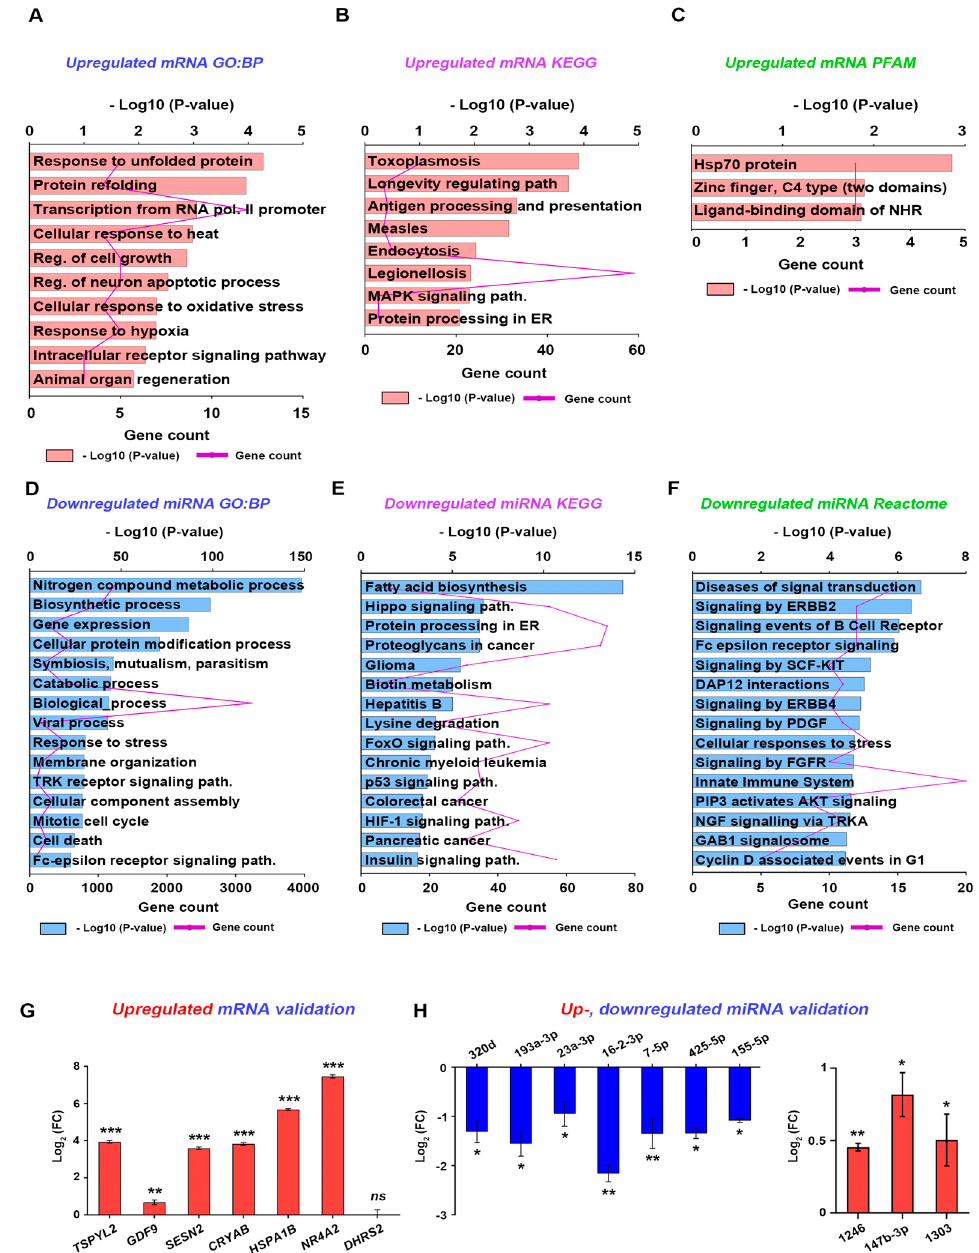
Figure 6. In silico analysis for the pharmacological mechanism of 3f and the validation in hTERT02.3 cells. Bioinformatics analysis using 150 DEGs or 21 DE miRNAs regulated by CAH in non-small cell lung cancer cell lines (NSCLC: SK-MES-1 and NCI-H226 cell lines) [11] was performed. ( A , D ) Gene ontology (GO), ( B , E ) Kyoto encyclopedia of genes and genomes (KEGG), and ( C , F ) protein domain analyses were performed using DAVID bioinformatics resources (https://david.ncifcrf.gov/; ac- cessed on 10 March 2022) and PFAM protein family database (https://pfam.xfam.org/; accessed on 10 March 2022). The bar graph represented the value of ‘ − log ( p -value)’, and the line graph showed the gene counts. ( G ) The mRNA levels of seven coding genes related to cell growth and oxidative stress were validated in hTERT02.3 cells with or without 3f treatment by qPCR. ** p < 0.01 and *** p < 0.001. ( H ) The miRNA levels of 10 miRNAs related to cell cycle were validated in hTERT02.3 cells by qPCR. * p < 0.05 and ** p <